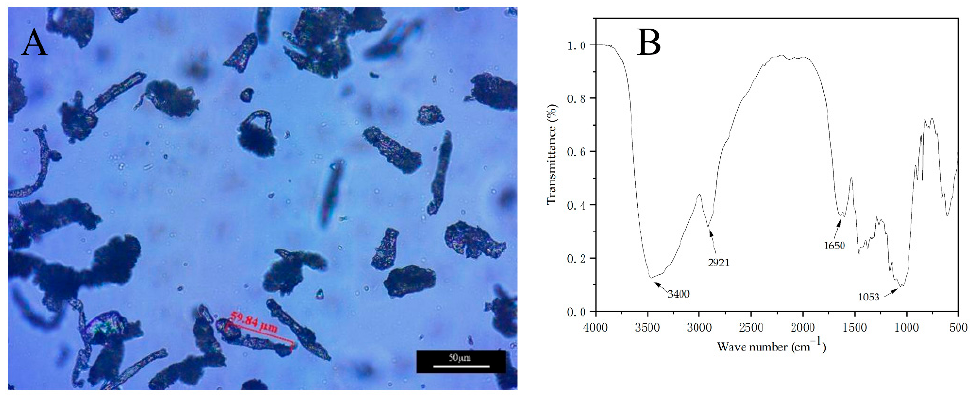
Figure 1. ( A ) Optical micrograph and ( B ) infrared spectrum of treated rice husk powder.